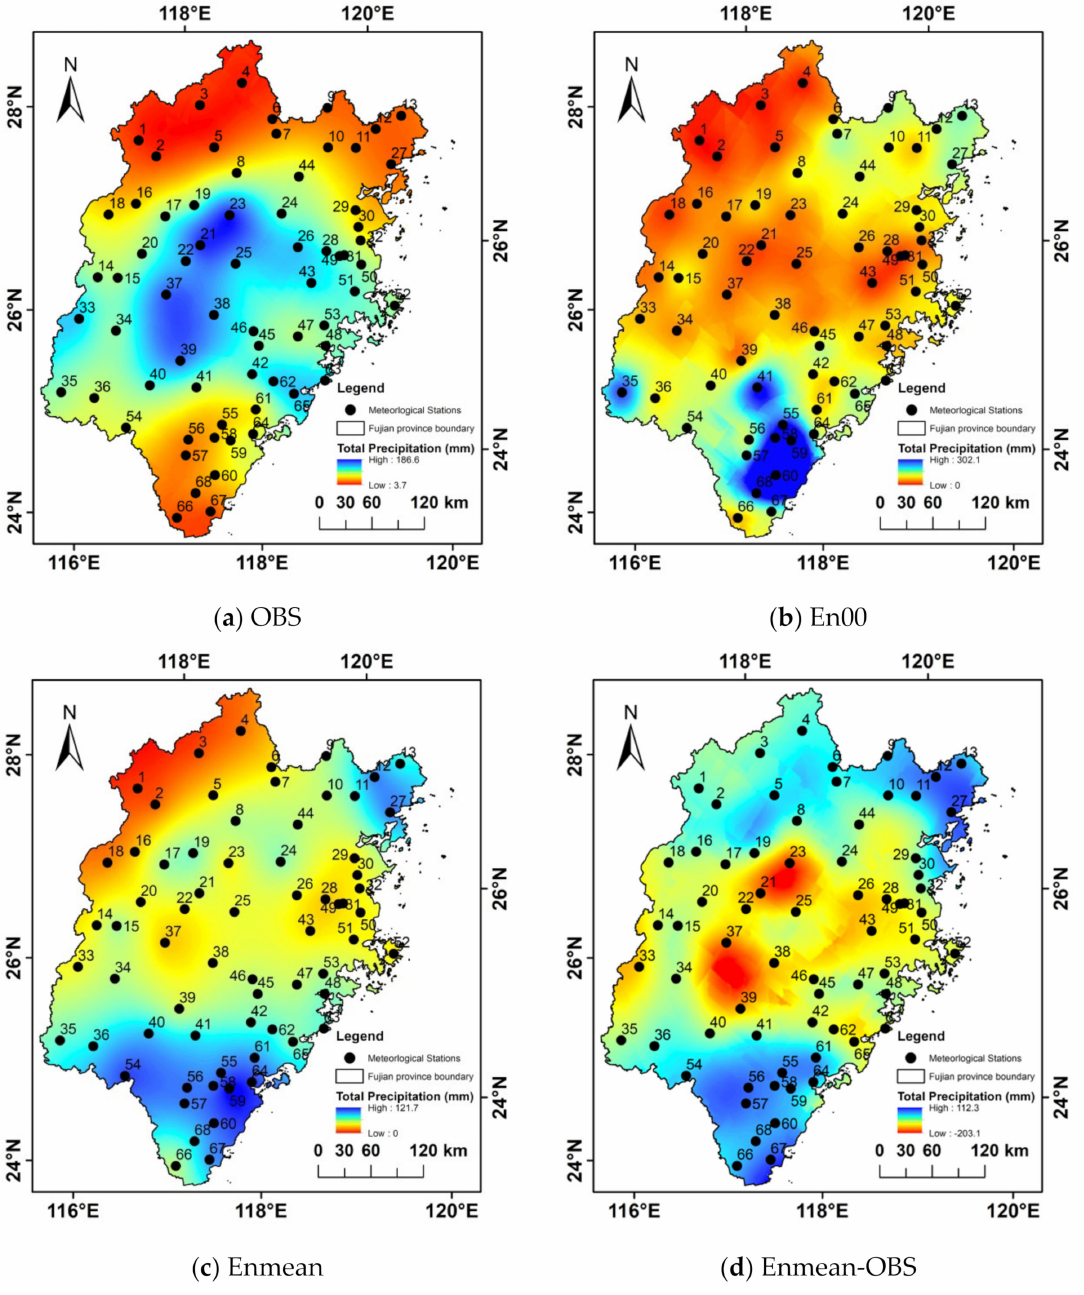
Figure 5. Spatial distribution of TCP from 01 UTC 15 June to 18 UTC 16 June 2010: ( a ) Distribution of interpolated TCP from observation; ( b ) distribution of interpolated TCP from En00; ( c ) distribution of interpolated TP from Enmean; ( d ) bias distribution of interpolated Enmean compared to observation (Enmean minus observation). The black dots represent the meteorological